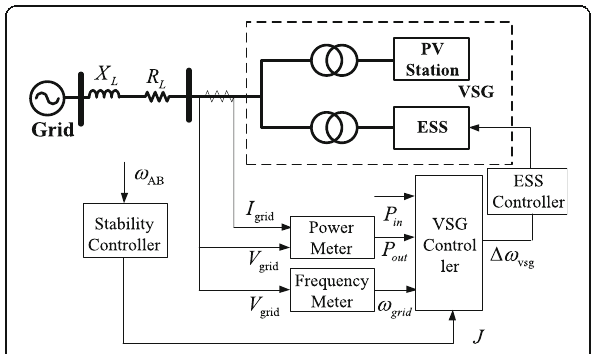
Fig. 1 Overall control scheme of the PV-VSG control